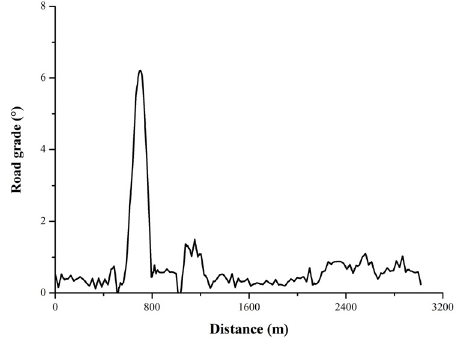
Figure 5. Smooth driving cycle (velocity-time).